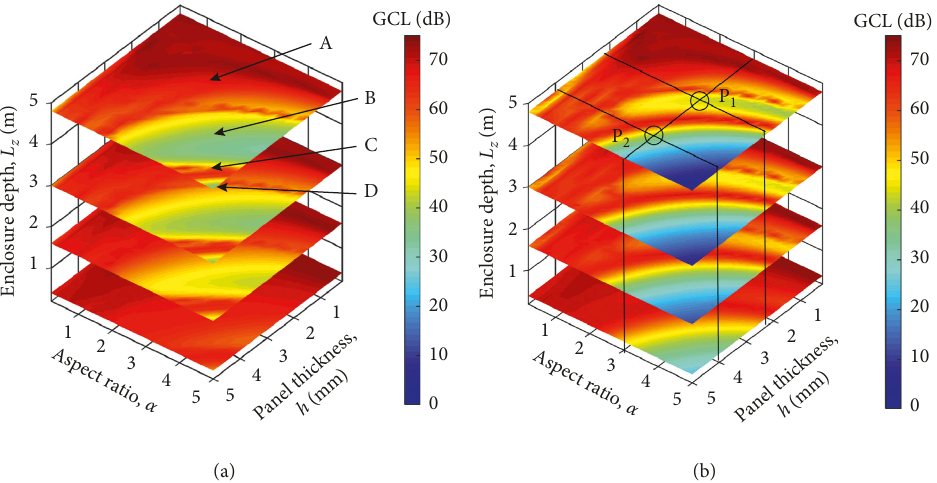
Figure 11: Comprehensive effect of structural parameters on the global coupling level of the coupled system: enclosure depth L 1.6m, 3.0 m, and 4.8m. (a) Simply supported panel. (b) Clamped panel.